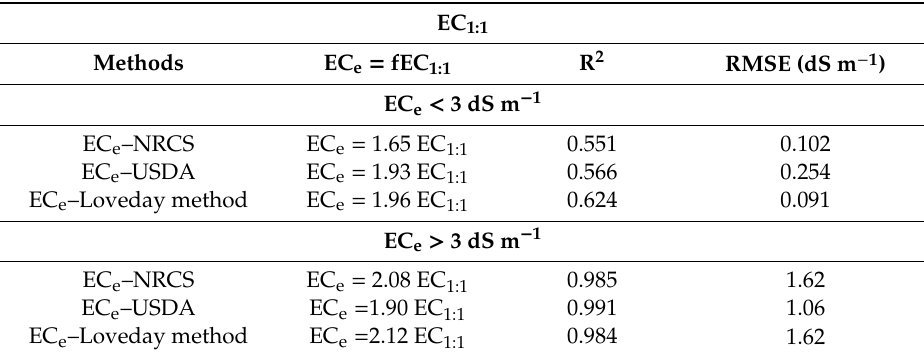
Table 7. Regression equations describing the relation between saturated paste extracts EC e and EC 1:1 determined by three di ff erent methods with the coe ffi cients of determination (R 2 ) and root mean square errors (RMSE) for all soil examined for EC e < 3 dS m − 1 and EC e > 3 dS m − 1